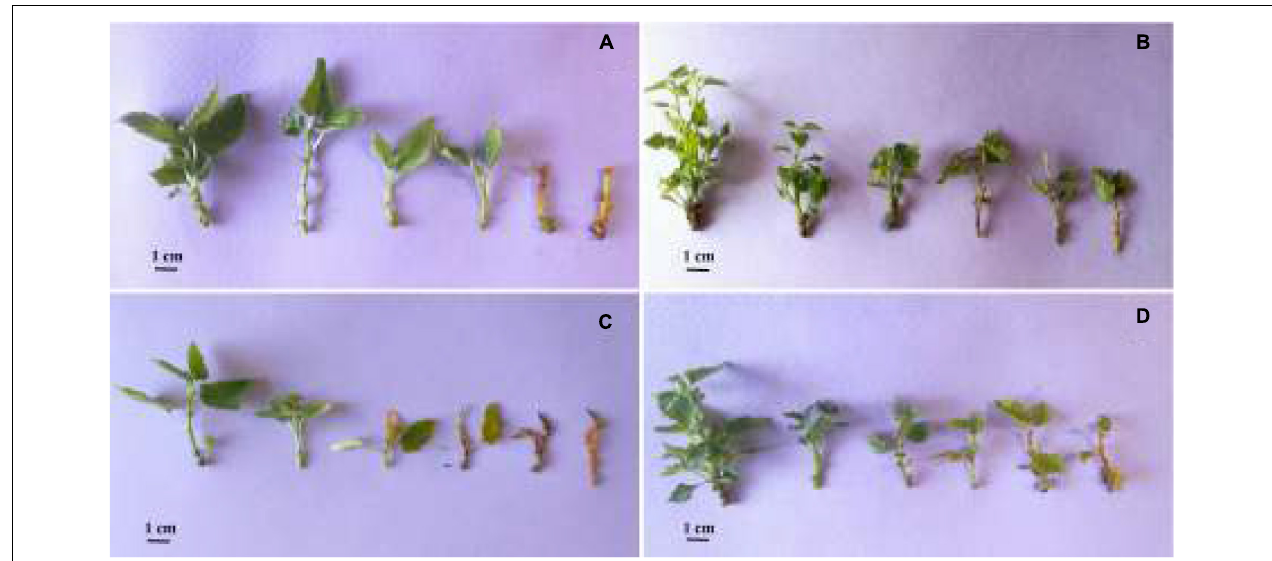
FIGURE 2 | In vitro responses of diploid and tetraploid explants of ‘Sabz’ and ‘Torsh’ fig cultivars, 14 days after subjecting to different water stress treatments. In each section (A–D) , the explants belonged to PEG treatments of 0, 5, 10, 15, 20, and 25%, from left to right, respectively. (A) Diploid explants of ‘Sabz’ cultivar, (B) tetraploid explants of ‘Sabz’ cultivar, (C) diploid explants of ‘Torsh’ cultivar, and (D) tetraploid explants of ‘Torsh’ cultivar.